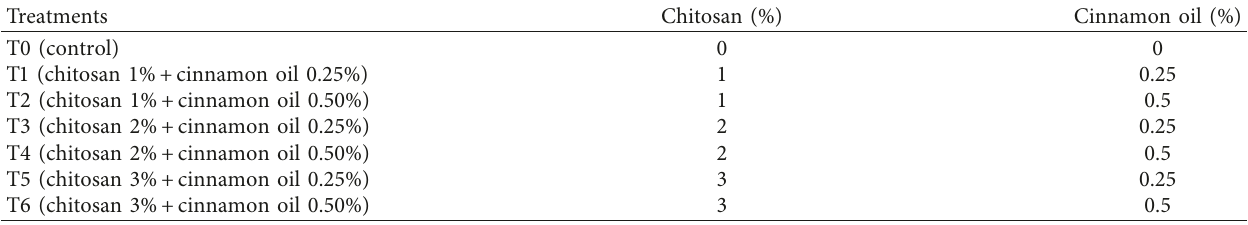
Table 1: Formulations of edible coating materials for the treatment of pomegranate arils. Treatments Chitosan (%) Cinnamon oil